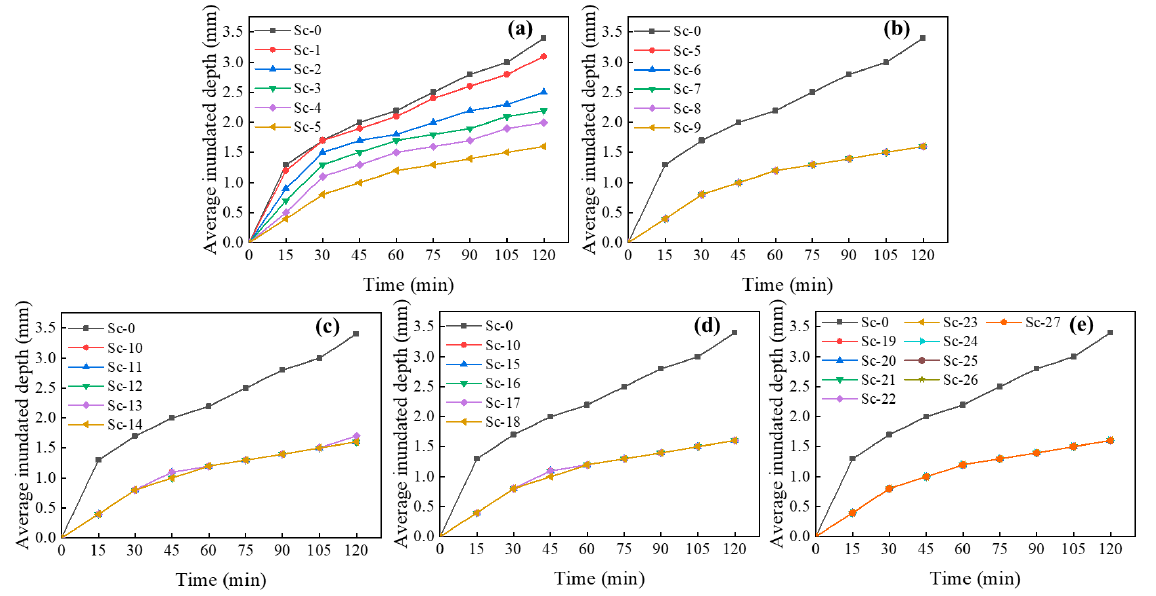
Figure 19. The time series plot of AID in 3 h event in considered scenarios of ( a ) connectedness of GR; ( b ) connectedness of RG; ( c ) edge density of GR; ( d ) edge density of RG; ( e ) flow distance of RG.